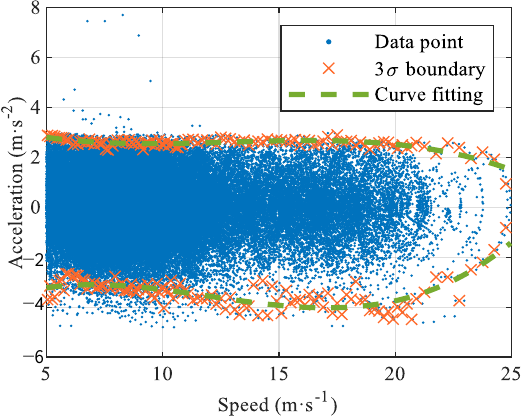
Figure 3. Dynamic characteristics of speed-acceleration based on training dataset.